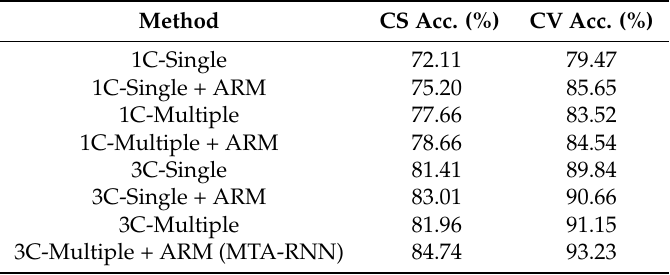
Table 3. Comparison of ablation experiment results on the NTU RGB+D dataset, which demonstrated the performance of multi-channel, multi-term TS-LSTM and the ARM in MTA-RNN. ARM: Attention Recalibration Module. 1C: one channel. 3C: three channel. MTA-RNN: Multi-Term Attention Recurrent Neural